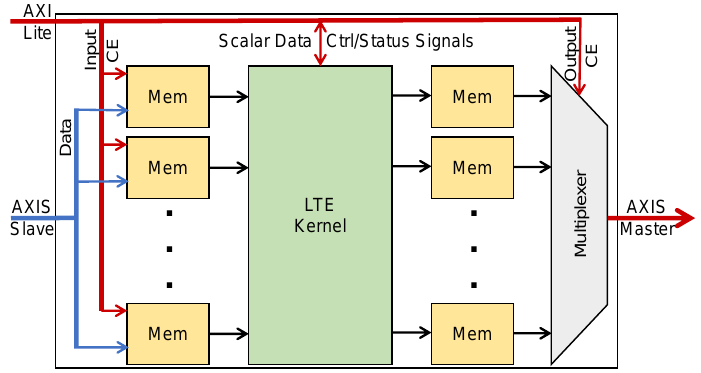
Figure 2. The structure of the Kernel_Wrapper